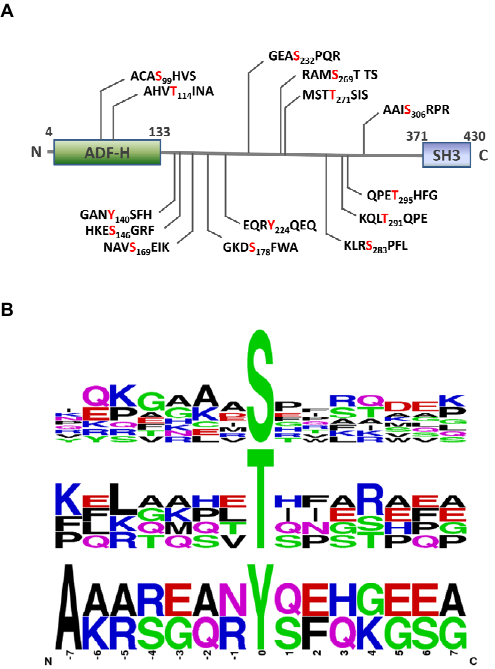
Figure 5. Graphical display and motif analysis of Phosphosites of HIP-55 Protein. ( A ) Graphical display of phosphosite mapping of HIP-55 Protein; ( B ) Frequency distribution of amino acid residues surrounding phosphorylation sites at positions − 7 to